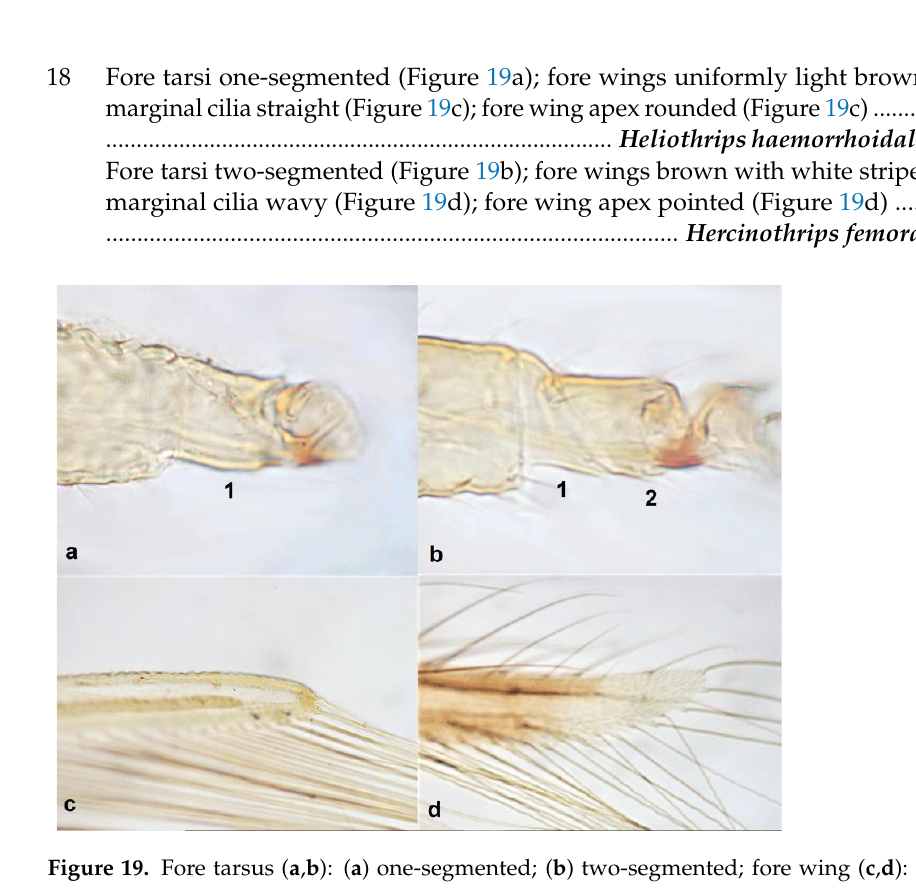
Figure 19. Fore tarsus ( a , b ): ( a ) one-segmented; ( b ) two-segmented; fore wing ( c , d ): ( c ) postero- marginal cilia straight and apex rounded; ( d ) postero-marginal cilia wavy and apex pointed. 19 Pronotum considerably narrower at anterior margin than at posterior margin (Figure 20a).................................................................................... Chirothrips Haliday .. 20 Pronotum having the same width at both margins (Figure 20b) ˙.................................. 22